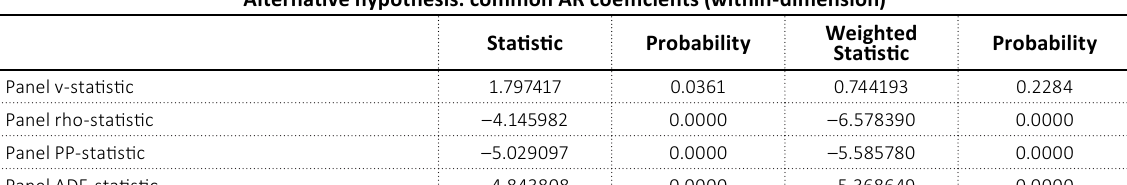
Table 4. Summary results of panel cointegration Alternative hypothesis: common AR coefficients (within-dimension)